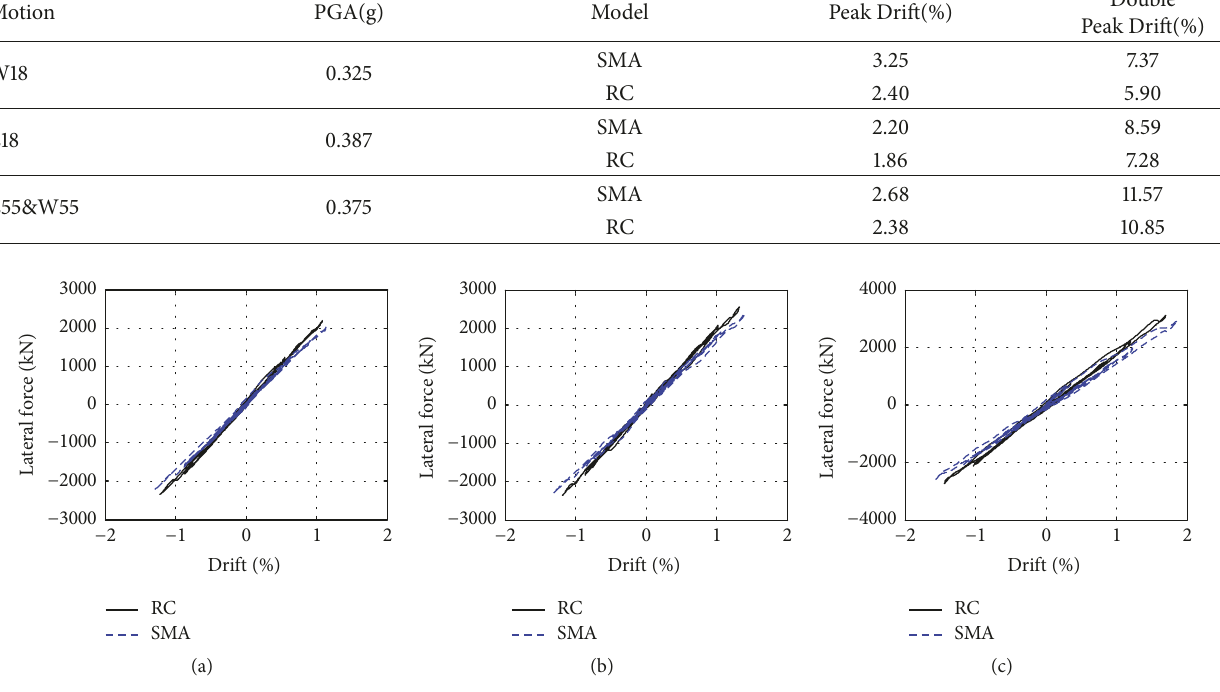
Figure 9: Force displacement hysteresis of the column: (a) W18 synthetic motion, (b) E18 synthetic motion, and (c) E55 synthetic